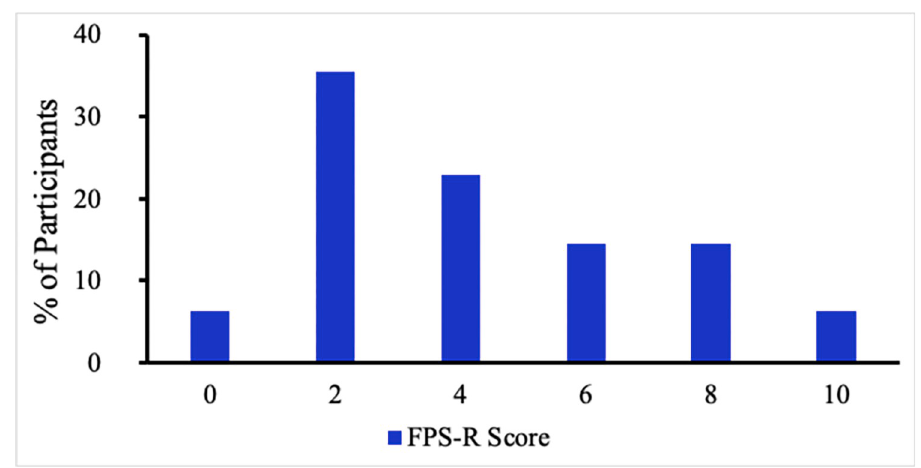
Fig 2. Self-reported pain after NP swab using revised Face Pain Scale (FPS-R, percent of participants).